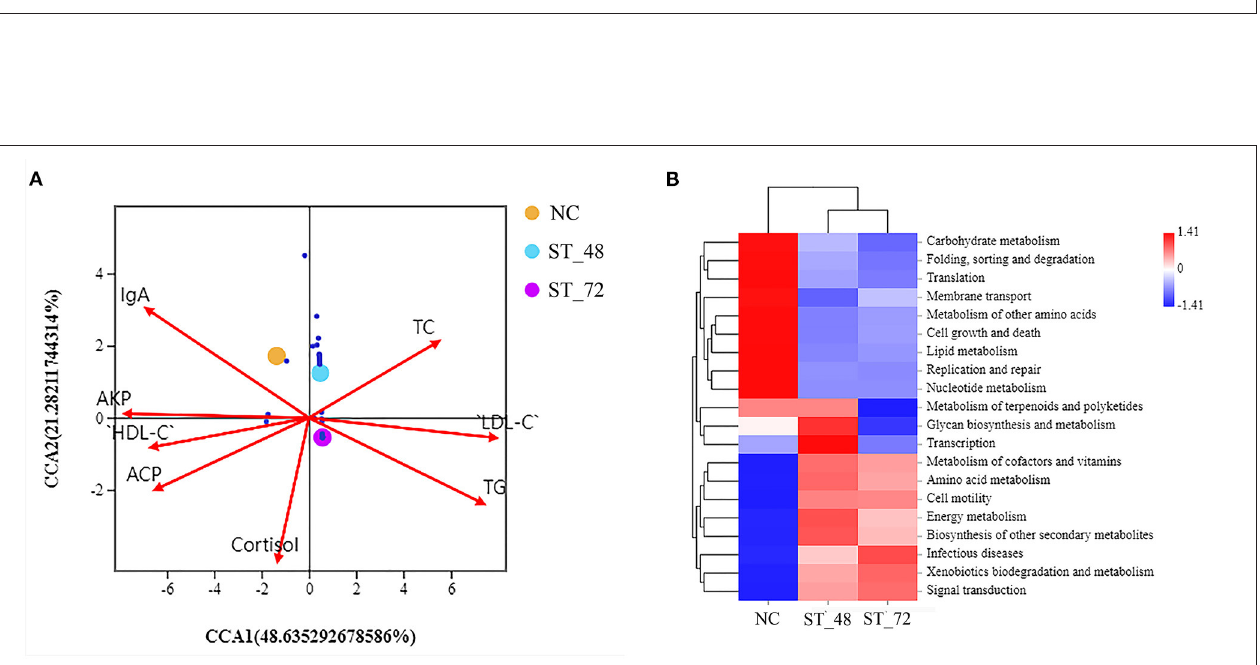
FIGURE 6 | Correlation analysis between different bacteria and environmental factors and pathway enrichment analysis. (A) Corresponding sequence diagram of the top 30 genera with significant differences and environmental factors based on CCA analysis. (B) KEGG pathway enrichment heatmap showing the alteration in biological processes and metabolisms under starvation stress piglets. Red, positive correlations; blue, negative correlations.